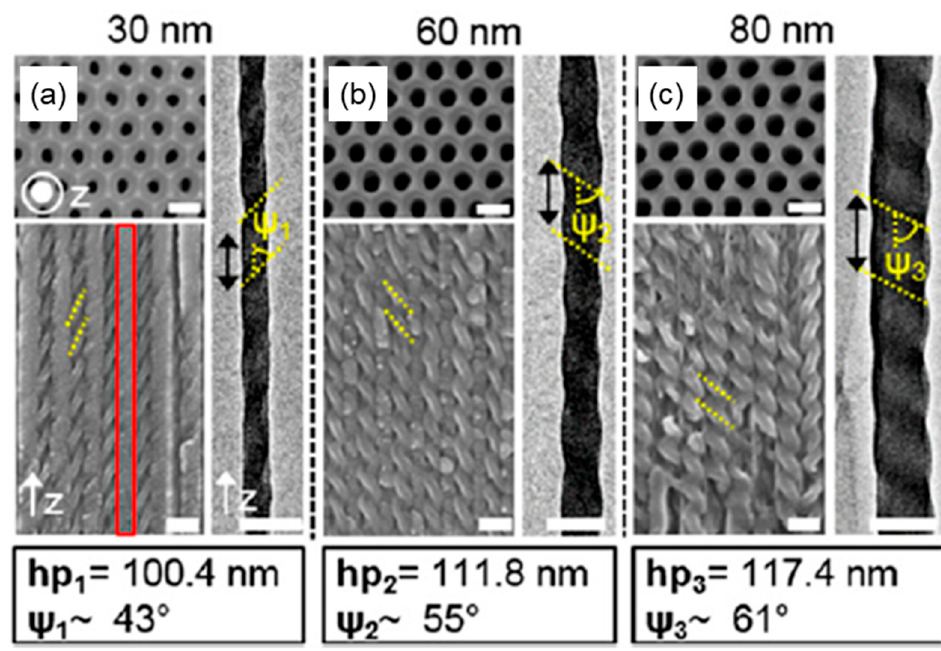
Figure 5. SEM images of individually grown HNFs in each pore of AAO whose D p is ( a ) 30 nm, ( b ) 60 nm, and ( c ) 80 nm. (Scale bar: 100 nm) Reprinted with permission from [35], Copyright 2014, National Academy of Sciences.